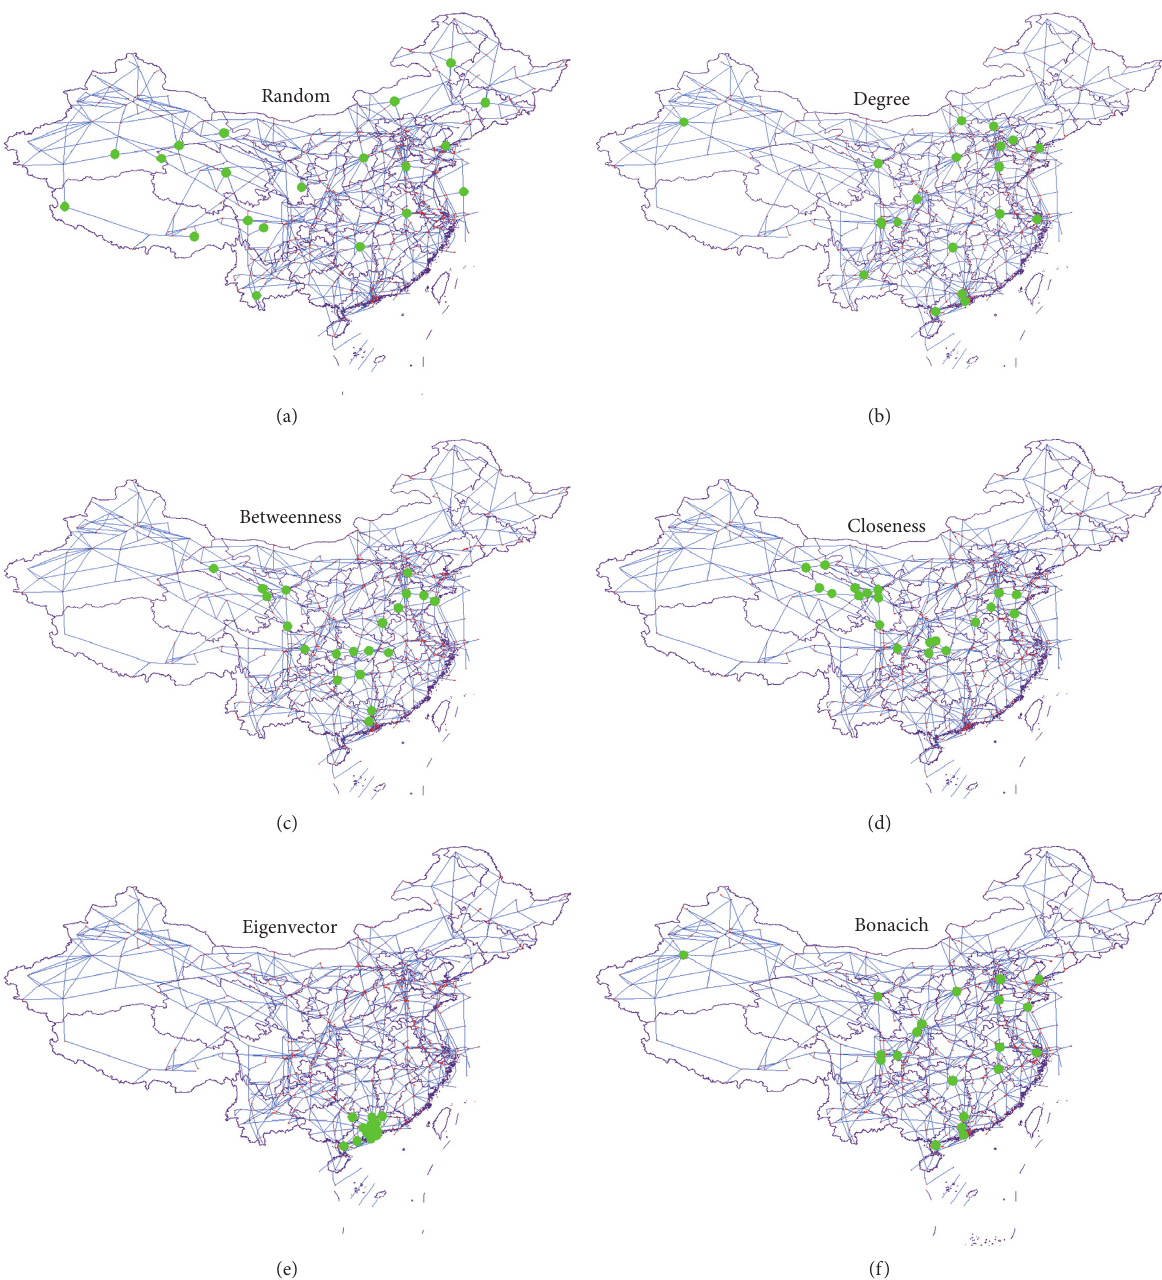
Figure 5: The top-20 nodes of ARRN ranked by random, degree, betweenness, closeness, eigenvector, and Bonacich metrics,